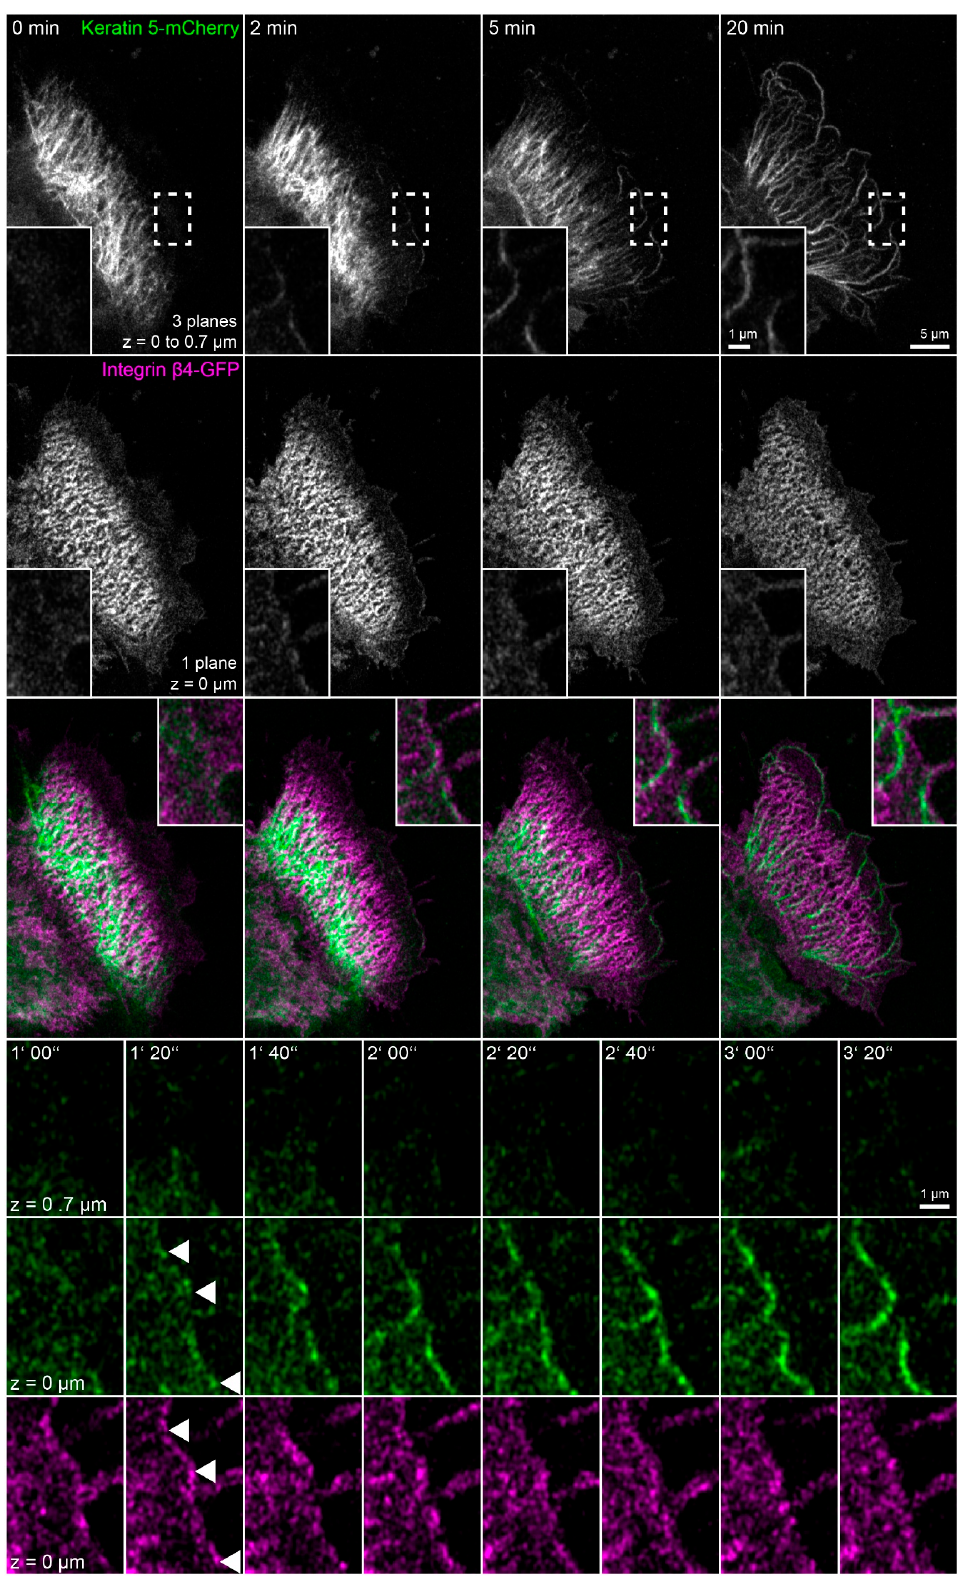
Figure 6. Growing keratin filaments appear at nascent hemidesmosomes after actin and microtubule disruption ( n = 6). The fluorescence images show the distribution of keratin 5-mCherry and integrin β 4-GFP in a living HaCaT cell before and after treatment with 3 µM latrunculin B and 20 µM nocodazole. The images of keratin 5-mCherry fluorescence present maximum intensity projections of the lower focal planes, and the images of the integrin β 4-GFP fluorescence show only the bottom